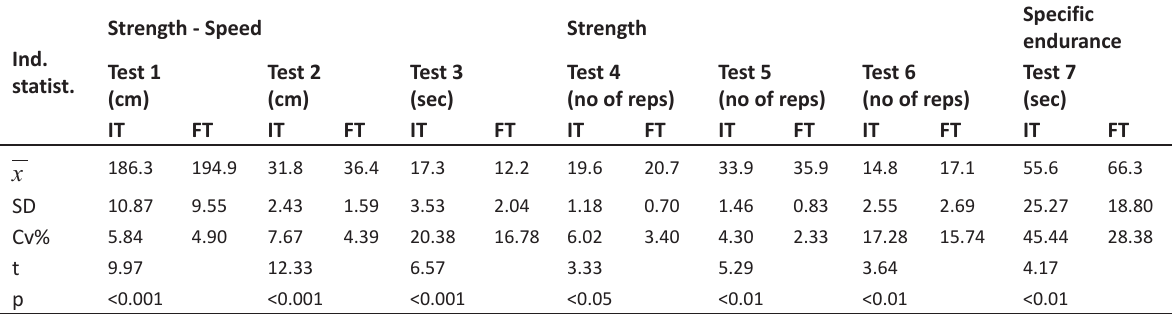
Table 1. Dynamics of physical training indicators of gymnasts aged 12-15 years (n =8)